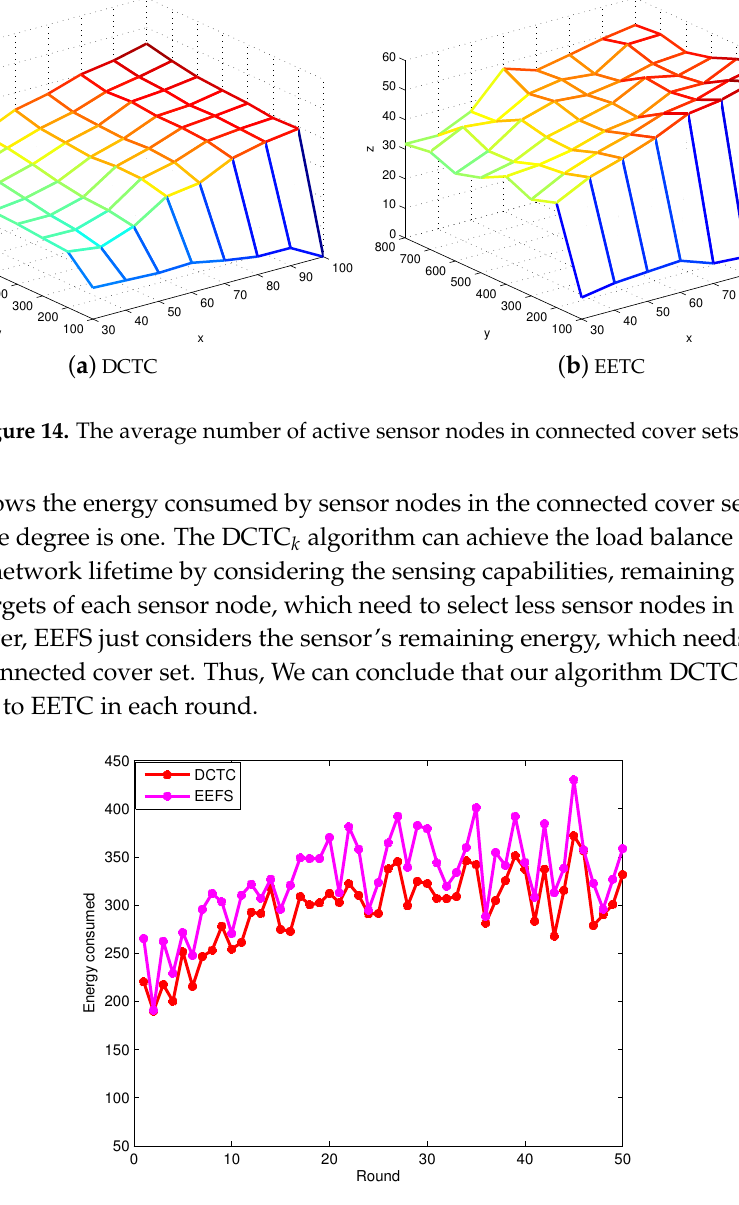
Figure 15. The energy consumed by all of the sensor nodes by the connected cover set in each